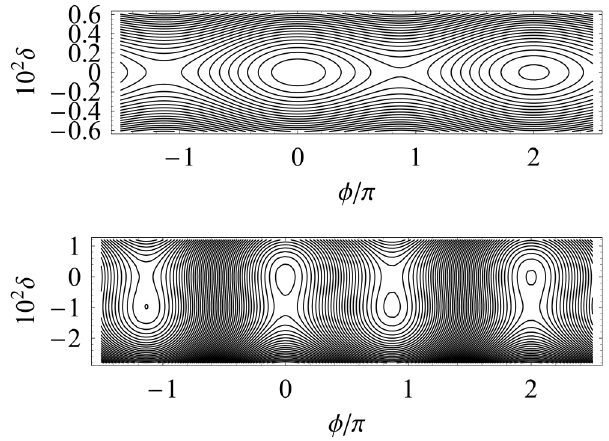
(cid:2) 2 = 2 (cid:4) 0 FIG. 3. The longitudinal wake field obtained by convolution